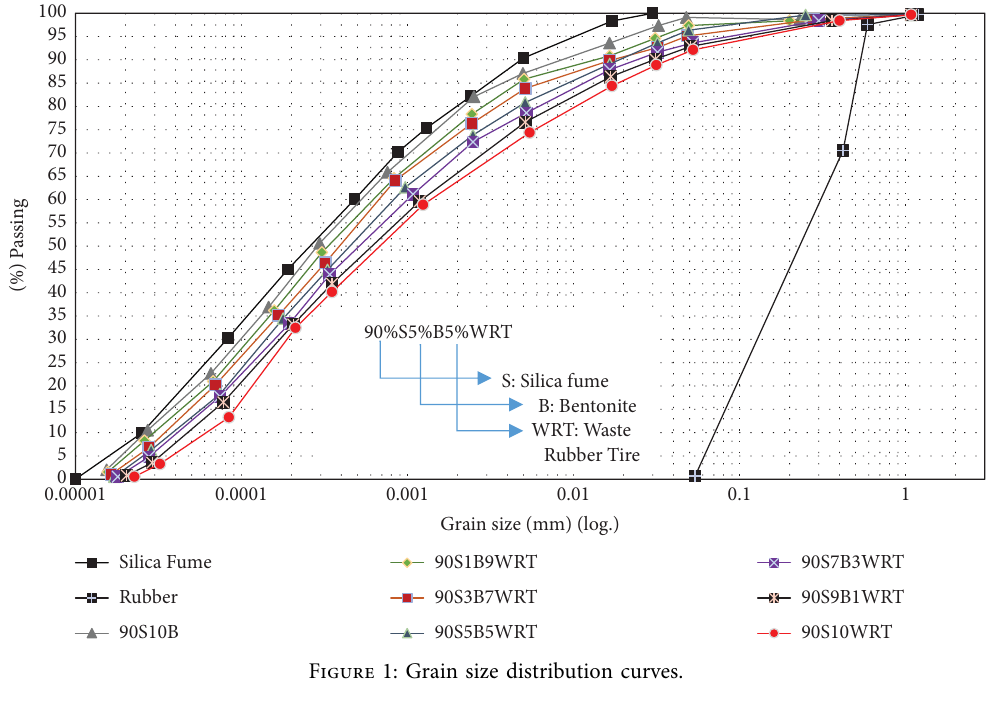
Figure 1: Grain size distribution curves.